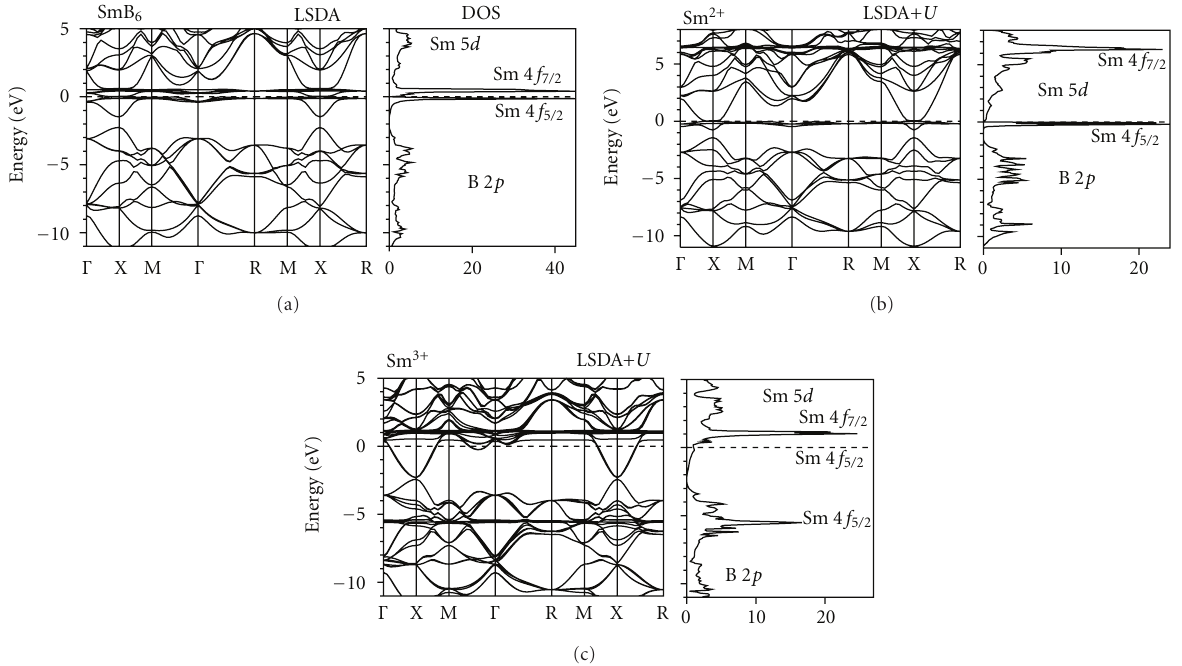
Figure 52: Self-consistent fully relativistic, spin-polarized energy band structure and total DOS (in states/(unit cell eV)) calculated for SmB 6 with LSDA and LSDA+ U approximations [349].